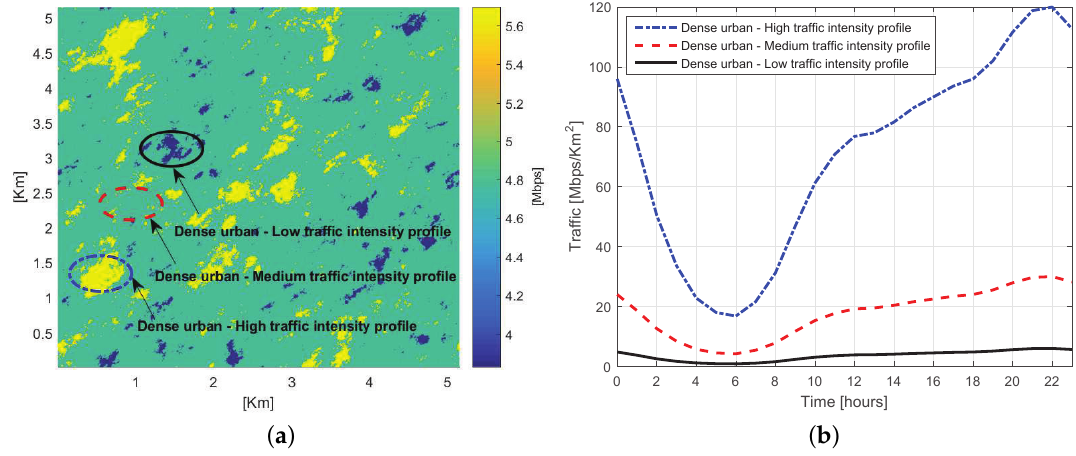
Figure 3. Examples of traffic intensity map and temporal traffic profile. ( a ) Traffic intensity map for an urban dense deployment. ( b ) Traffic time profile for three sub-regions of the traffic intensity map all corresponding to urban dense deployments with high, medium, and low peak traffic